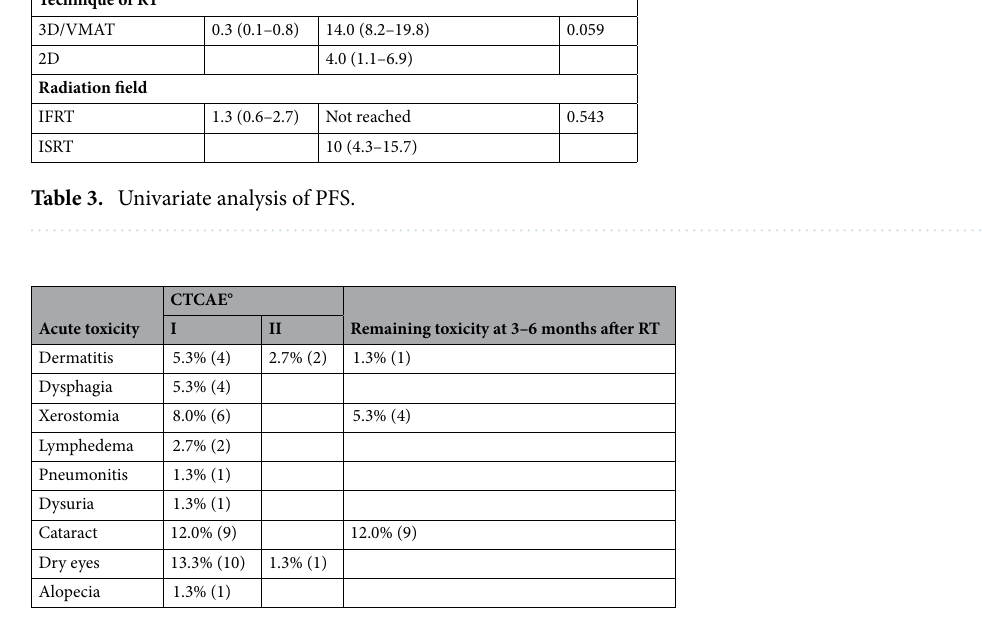
Table 4. Acute side effects of radiation therapy according to Common Terminology Criteria for Adverse Events ( CTCAE )